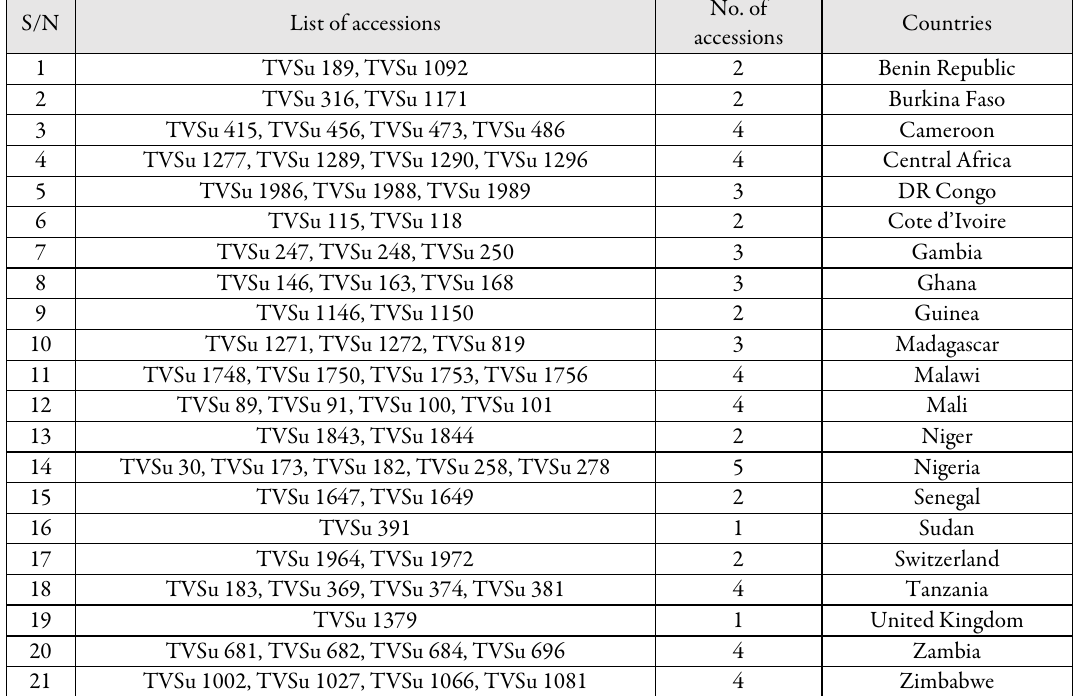
Table 1. List of Bambara groundnut accessions and their corresponding native